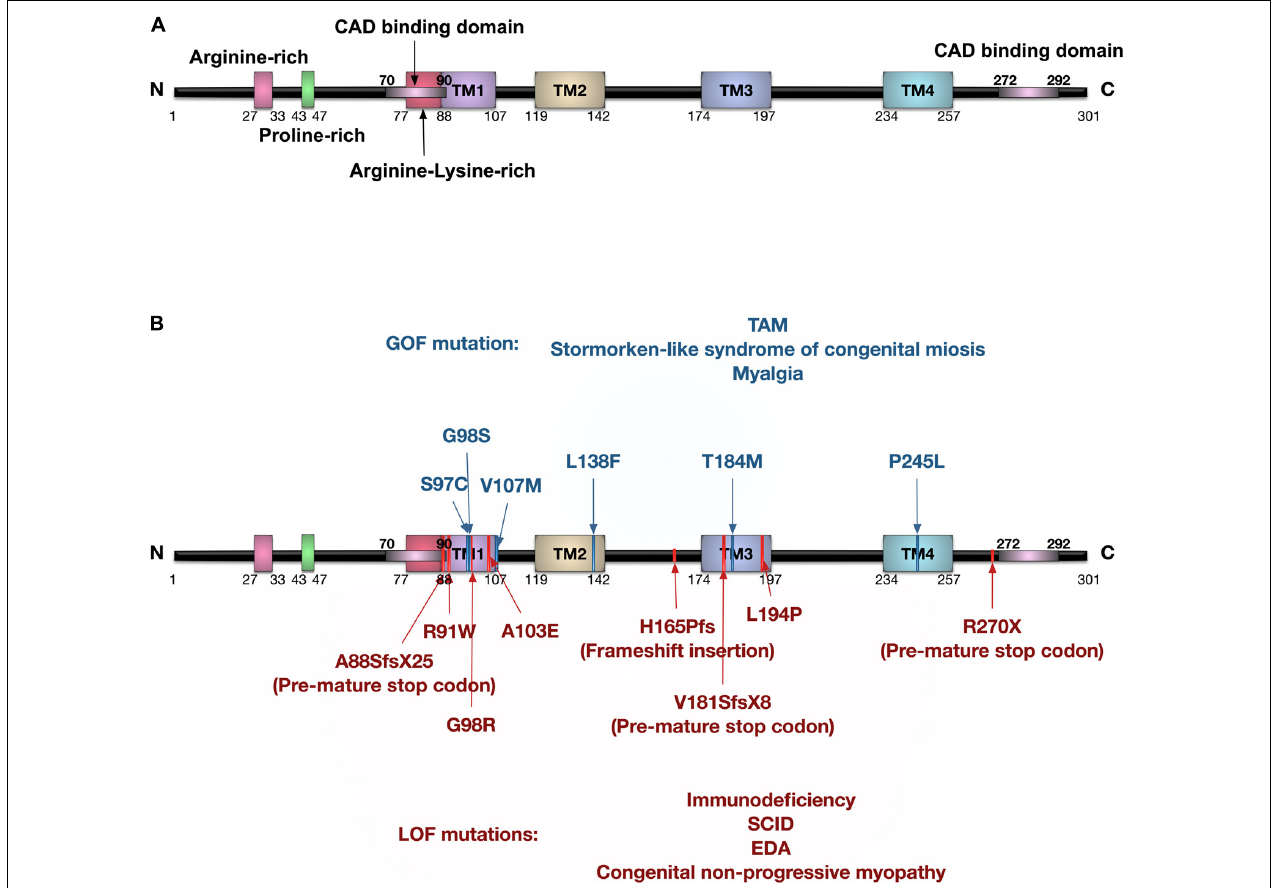
FIGURE 3 | Protein domain structure of human ORAI1 and the reported ORAI1 mutations. (A) Human ORAI1 protein comprises four transmembrane (TM) domains, two extracellular loops between TM1-TM2, and between TM3-TM4, one intracellular loop between TM2-TM3, arginine rich domain, proline-rich domain, arginine-lysine rich domain, amino terminus (N), and carboxy terminus (C) containing CRAC activation domain (CAD) binding domains (purple lines). (B) The blue lines represent gain-of-function (GOF) single nucleotide polymorphisms (SNPs) reported in tubular aggregate myopathy (TAM) patients with elevated CRAC channel activity. The red lines represent ORAI1 loss-of-function (LOF) mutations reported in patients with immunodeficiency, severe combined immune deficiency (SCID), and ectodermal dysplasia anhydrosis